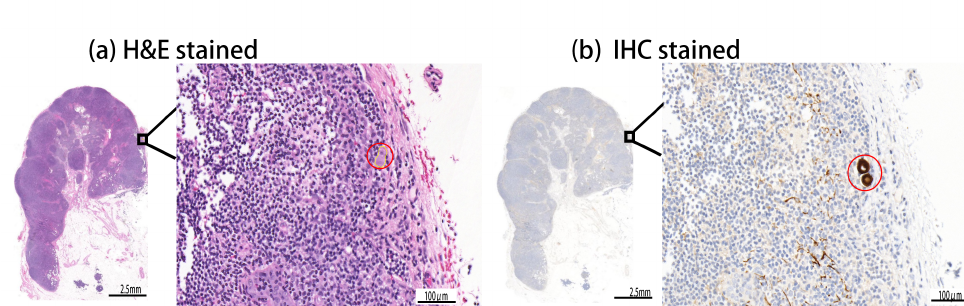
Figure 1. Challenges in finding tiny metastatic foci in gigapixel H–E WSIs. The segmentation of tiny micro metastases (denoted by red circles in ( a ) an H–E slide and ( b ) the associated IHC slide) is as challenging as finding a needle in a haystack. ( a ) Even in the high-magnification H–E image, ITCs are difficult to locate in humans. ( b ) In the high-magnification IHC image, metastases are visible as brown